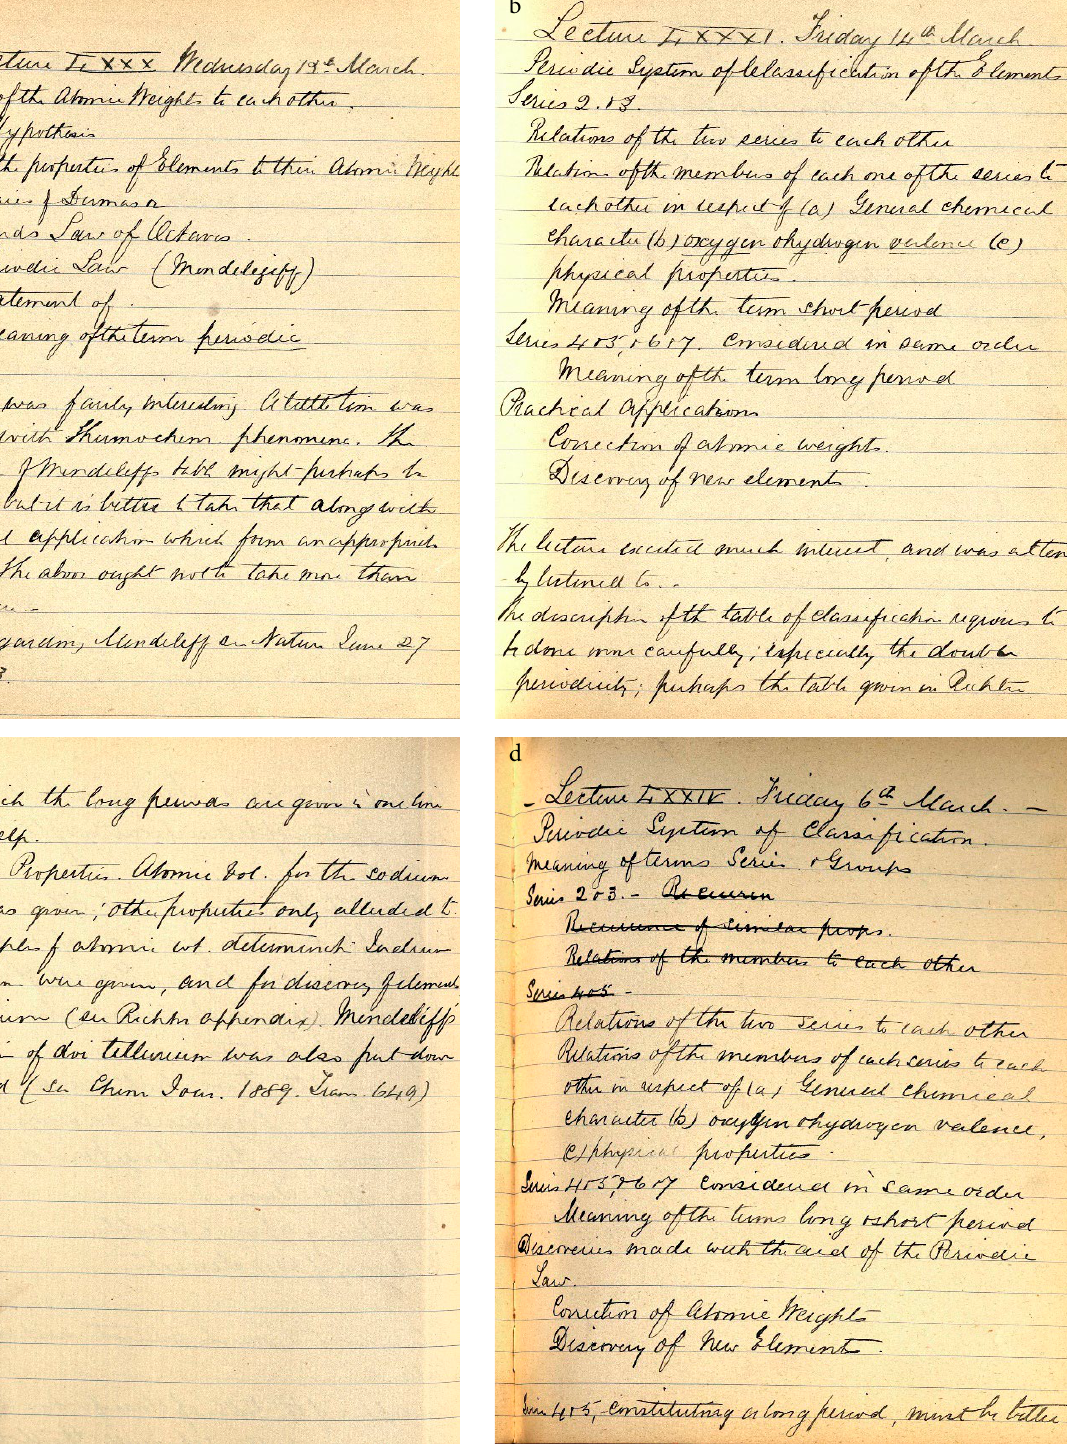
Figure 9. Thomas Purdie Syllabus of Lectures. Courtesy of University of St Andrews Library: